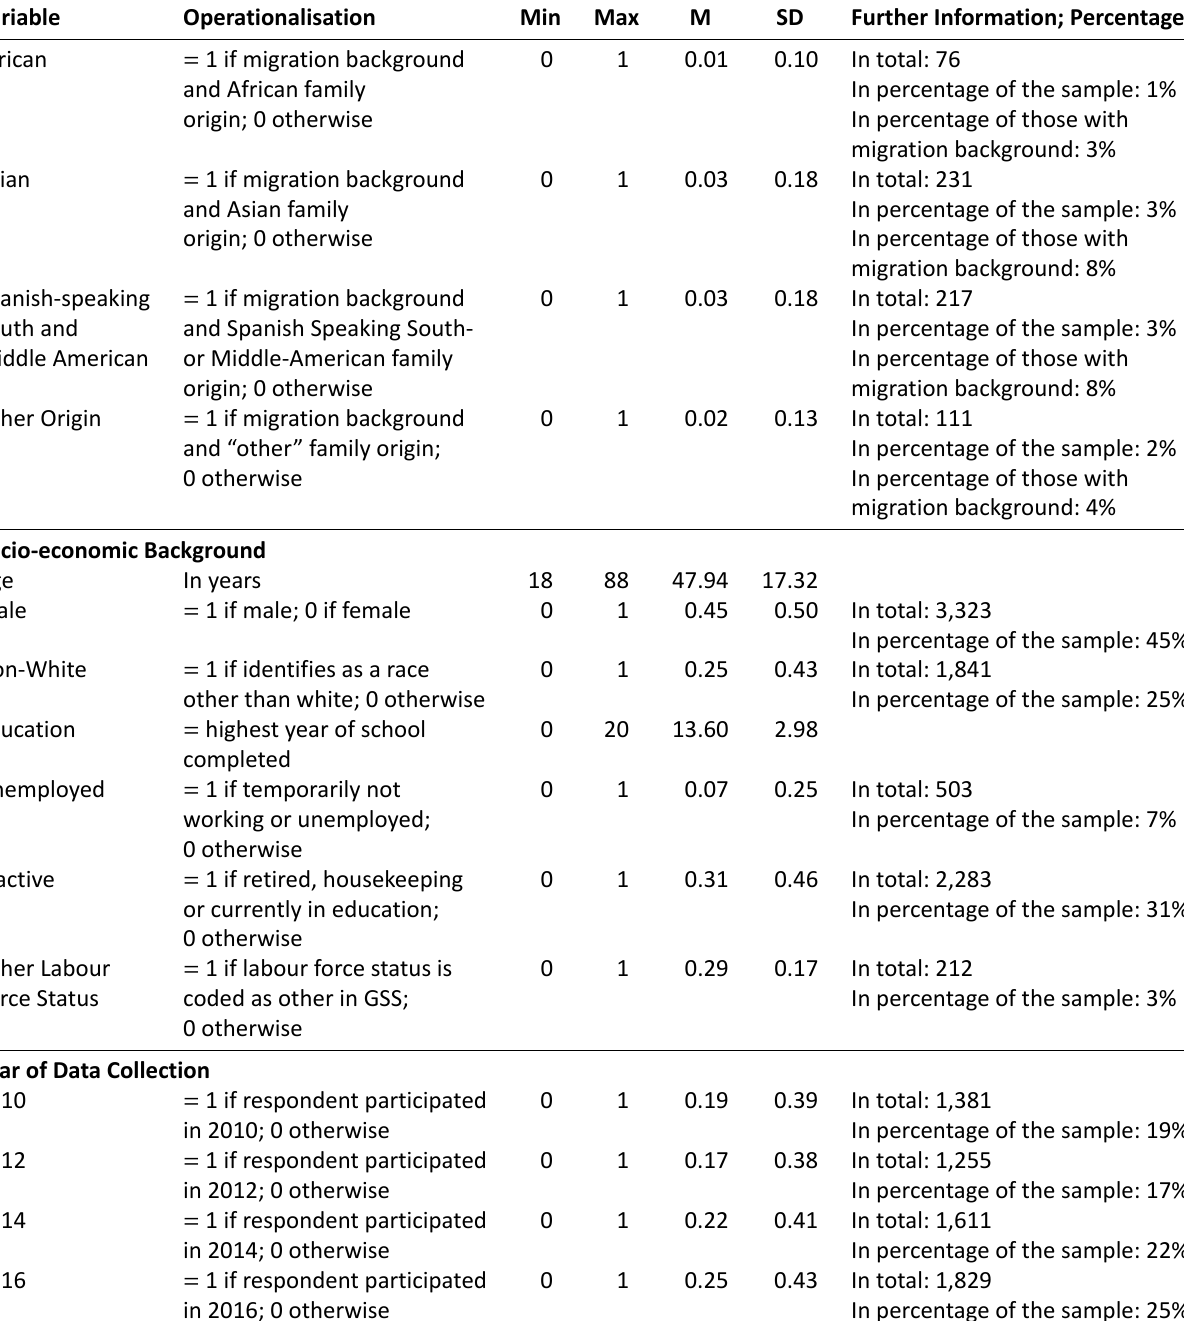
Table A2. (Cont.) Variables used in the analyses and descriptive statistics.